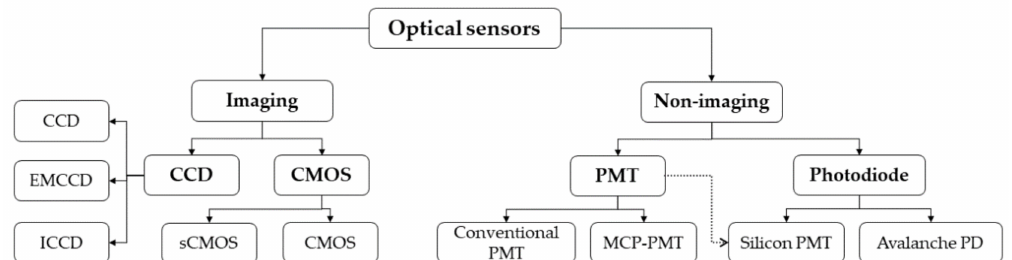
Figure 3. Based on the operating methods, the optical sensors for droplet microfluidic setups can be divided into two major categories—imaging and non-imaging. Photomultiplier tubes or photodiodes are widely used for non-imaging detection setups in droplet microflow cytometry (DMFC) where they detect the light level. If morphological and/or spatial information about cells is required, Charge-Coupled Device (CCD) or Complementary Metal Oxide Semiconductor (CMOS) type imaging sensors are preferred.